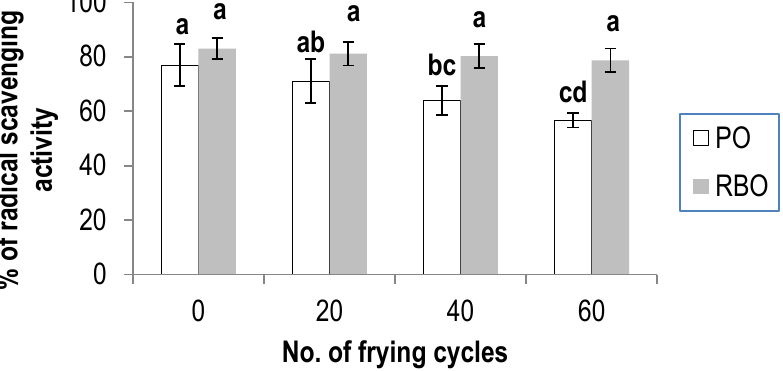
after frying for 60 min. Figure 1. The percentage of radical-scavenging activity in palm oil and rice bran oil over the 60th batch of deep-frying at a concentration of 70 mg/mL. The values given are means ± standard deviation of a triplicate analysis. The values marked with the same letters are not significantly different at p < 0.05 analyzed using the Duncan multiple range test. PO, palm oil; RBO, rice bran oil.